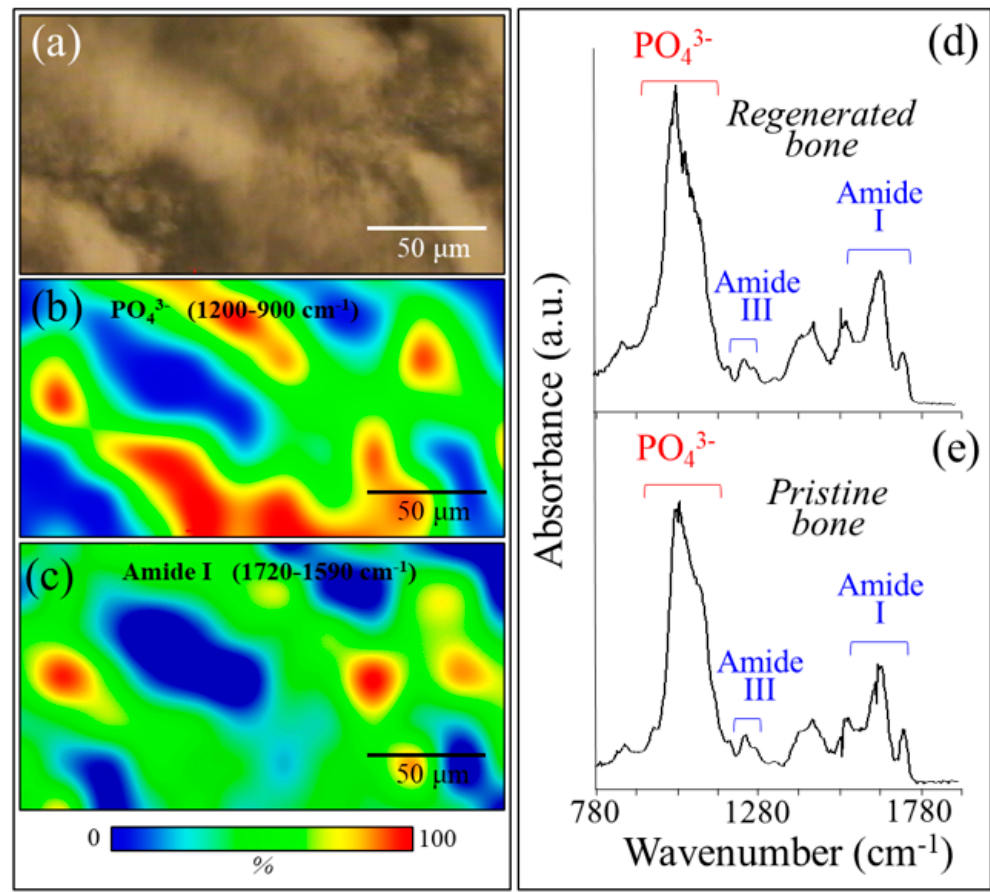
Figure 8. ( a ) Bright-field optical micrograph and related synchrotron radiation–based Fourier transform Figure 8 infrared (SR-FTIR) image of ( b ) apatite and ( c ) collagen structures in a microscopic portion within the regenerated bone sca ff old area. In ( d ) and ( e ), the SR-FTIR spectra of regenerated bone are shown in correspondence with the sca ff old and pristine cortical bone,